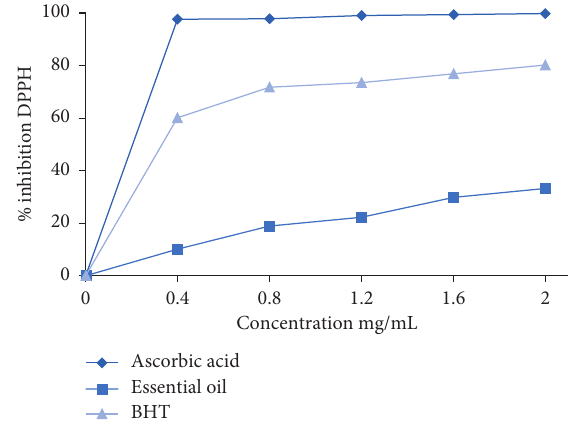
Figure 3: Percentage inhibition curve as a function of the concentration.